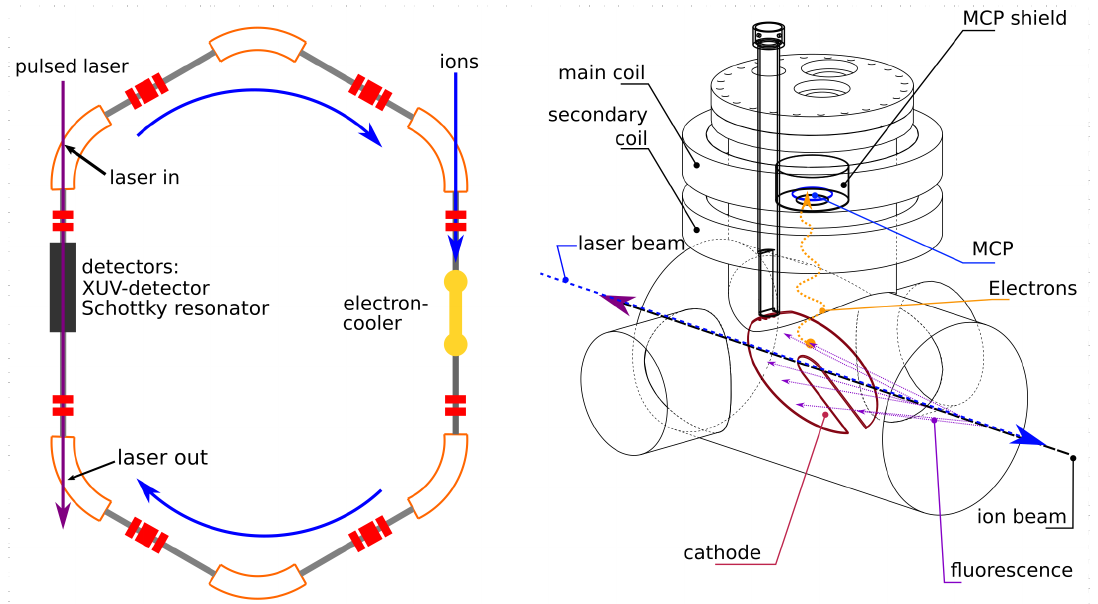
Figure 1. The Experimental Storage Ring (ESR) at GSI with the setup used for laser cooling experi- ments is shown on the left, and a schematic diagram of the XUV detector and its working principle is shown on the right